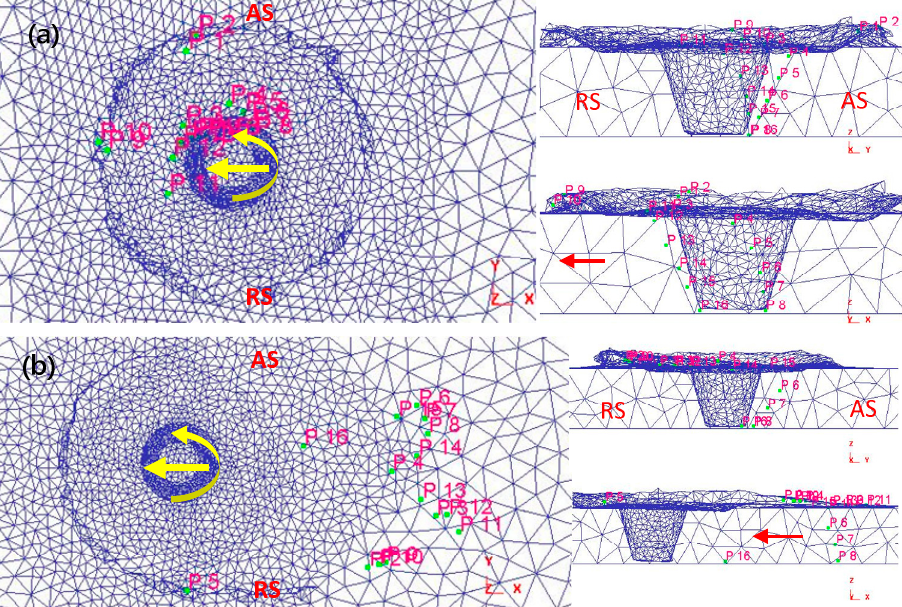
Figure 15. Material flow on the advancing side. ( a ) The tool is pressed down onto the given amount; and ( b ) the particles are deposited behind the tool.